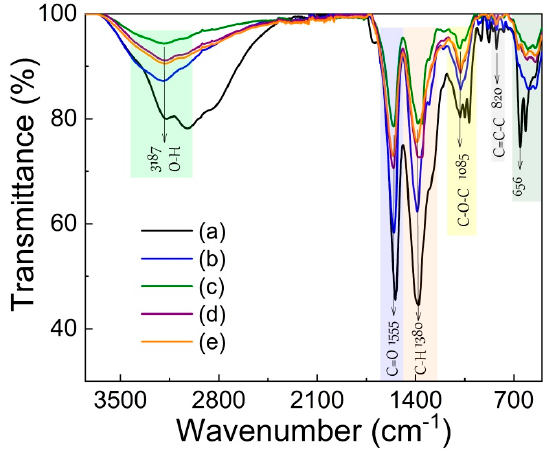
Figure 3. FTIR spectra of natural dye (in powder) that was extracted in different pH values: (a) 3.96, (b) 5.45, (c) 6.00, (d) 6.83, and (e) 8.02.